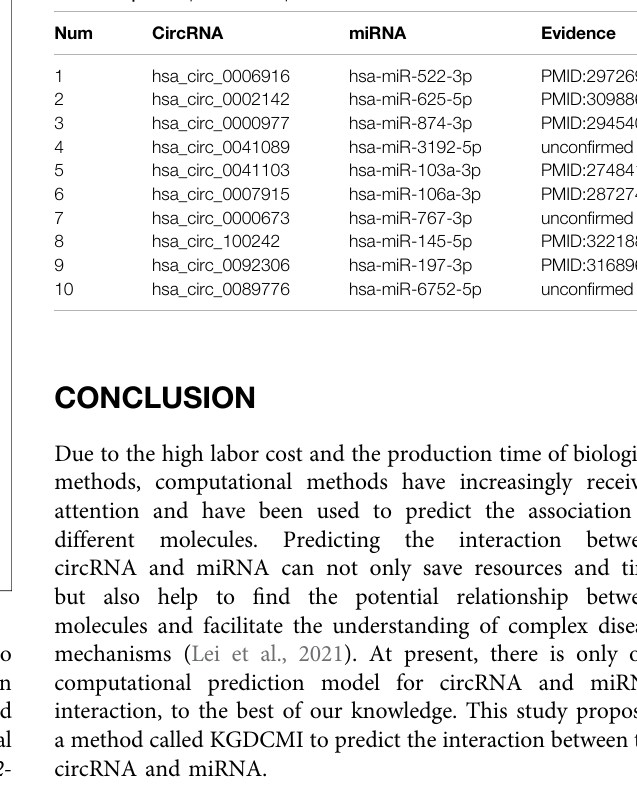
TABLE 4 | The top 10 results predicted in our model based on the